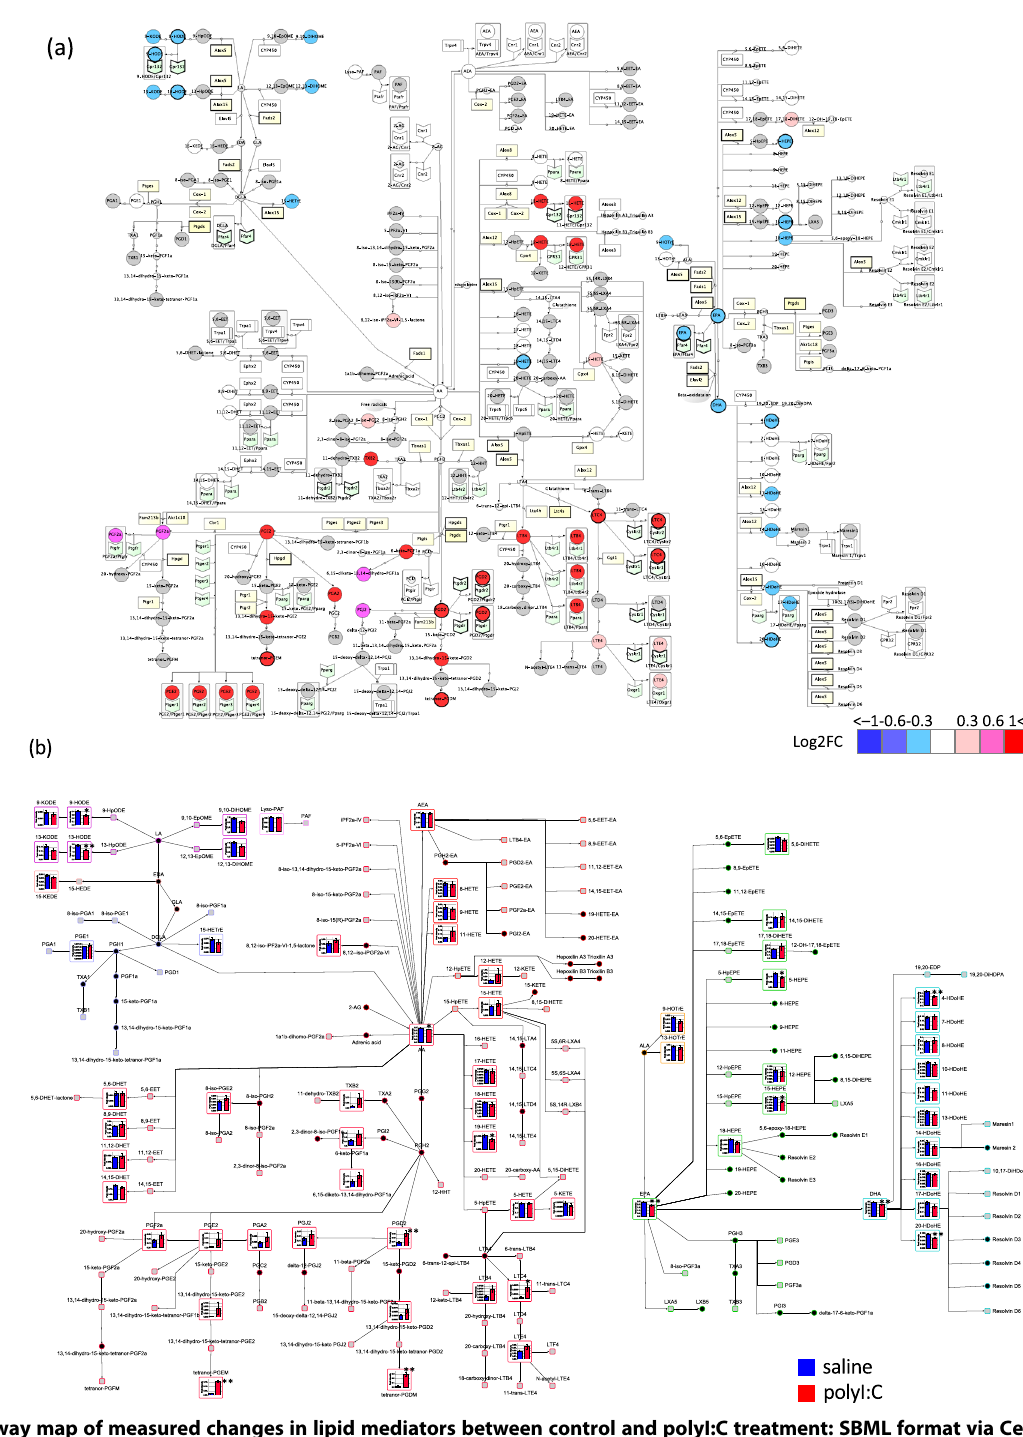
Fig. 2 Pathway map of measured changes in lipid mediators between control and polyI:C treatment: SBML format via CellDesigner; GML format via VANTED: effect of polyI:C treatment on lipid mediators in plasma. a Fold changes in lipid mediators induced by polyI:C versus control treatment, mapped in SBML format using CellDesigner. Metabolites not included and not detected are shown as small grey circles and larger grey circles, respectively. Metabolites showing a log2 fold change (polyI:C/saline) > 0.3 or < -0.3 ( P < 0.05) are drawn with a thick outline; related enzymes/receptors are highlighted. Lines with an arrow show a metabolic reaction; lines with an open circle, connected to a metabolic reaction, show an enzymatic reaction. The receptor, ion channel, and enzymes associated with the pathway of changed lipid mediator pro fi le is indicated by light green and light yellow symbols, respectively. The receptor, ion channel, and enzyme associated with the pathway of signi fi cantly changed lipid mediator between polyI:C and saline are drawn with a thick outline. b Mean (± s.e.m) amounts of lipid mediator measured in plasma after saline (blue column) and polyI:C (red column) treatment were mapped in GML format using VANTED. Metabolites not included and not detected in the analysis are shown as small black circles and grey squares, respectively. Lines with arrows show a metabolic reaction. Colors indicate the metabolite grouping for lipid derived mediators: red; AA, purple; LA, salmon pink; GLA and EDA, blue; DGLA, pink; Lyso-PAF and PAF, orange; AEA, yellow; ALA, light green; EPA, and light blue; DHA. ** P < 0.01, * P <